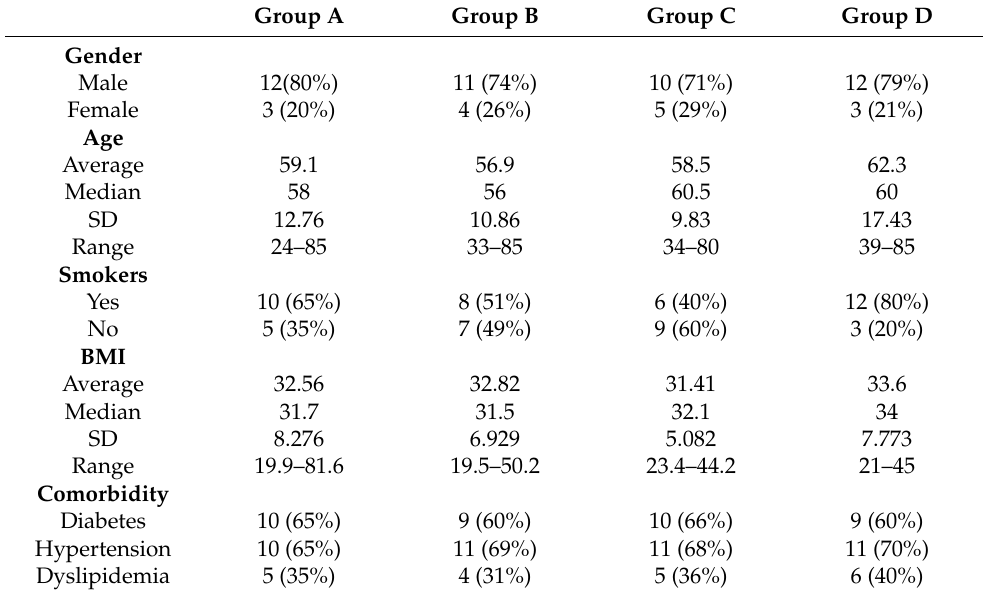
Table 2. Demographic data of